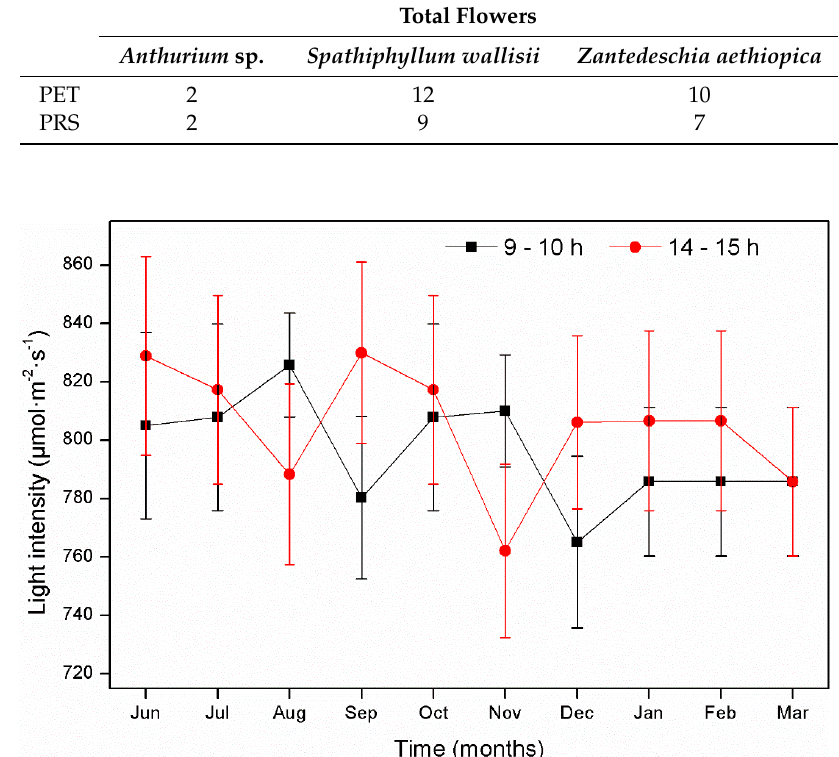
Figure 4. Light intensity registered at 9 to 10 h and 14 to 15 h during the experimental period. Vertical bars represent the standard error of the mean; values are given as the mean ± standard error.